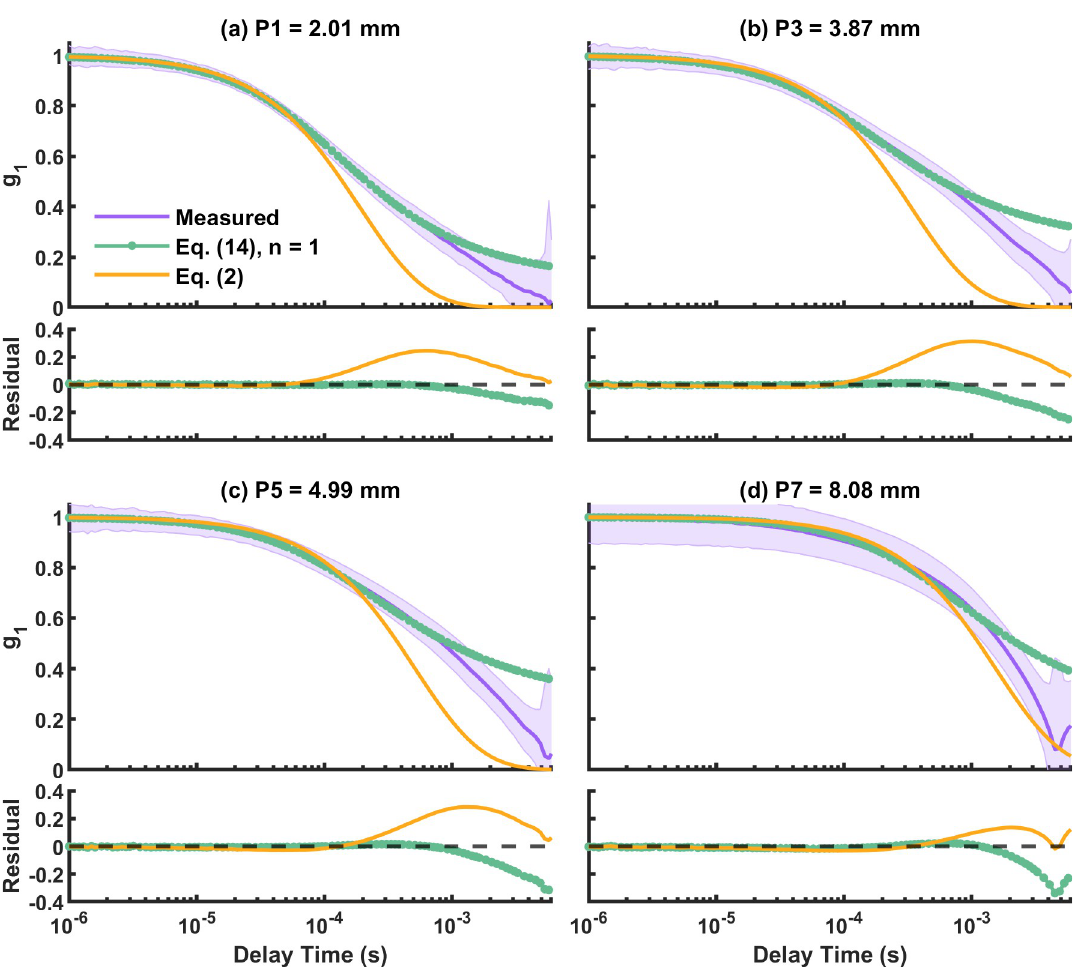
Fig 6. (a-d) Measured and fitted g 1 at SD3 (20 mm) for two-layer phantoms P1 (2.01 mm), P3 (3.87 mm), P5 (4.99 mm), P7 (8.08 mm). Purple: measured g 1 with standard deviation. Green with circle: two-layer model. Orange: single-layer model (Eq (2)).